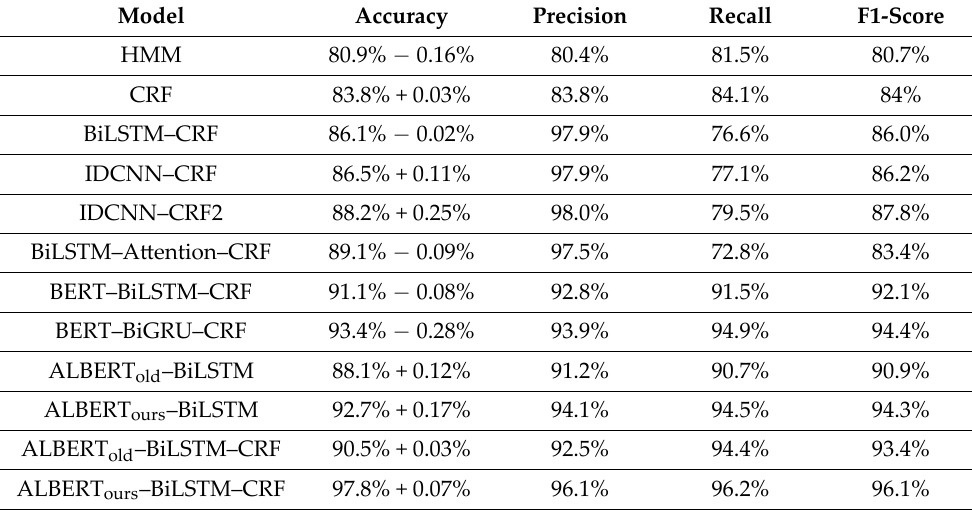
Table 9. Results of different models on